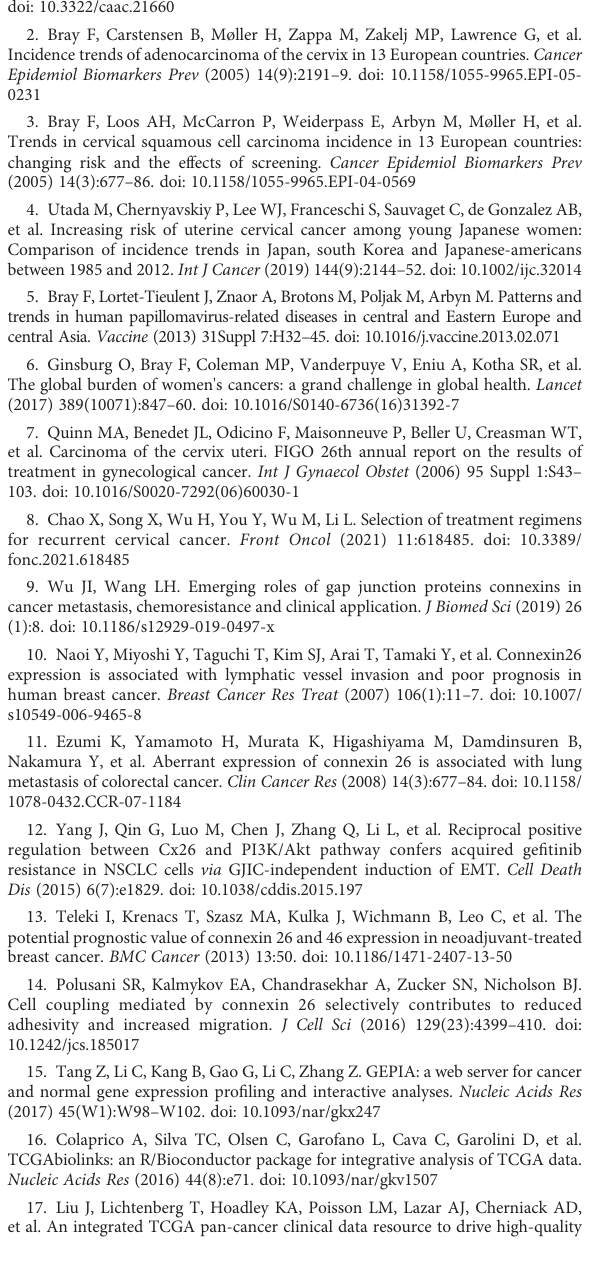
SUPPLEMENTARY FIGURE 3 Supplementary content for tumor immune microenvironment analysis. (A) Immune cell abundance analysis with 22 types of cell by CIBERSORTx; (B) The calculation of StromalScore, ImmuneScore, and ESTIMATEscore in the low and high GJB2 expression group. *p < 0.05, **p < 0.01, ns: not signi fi